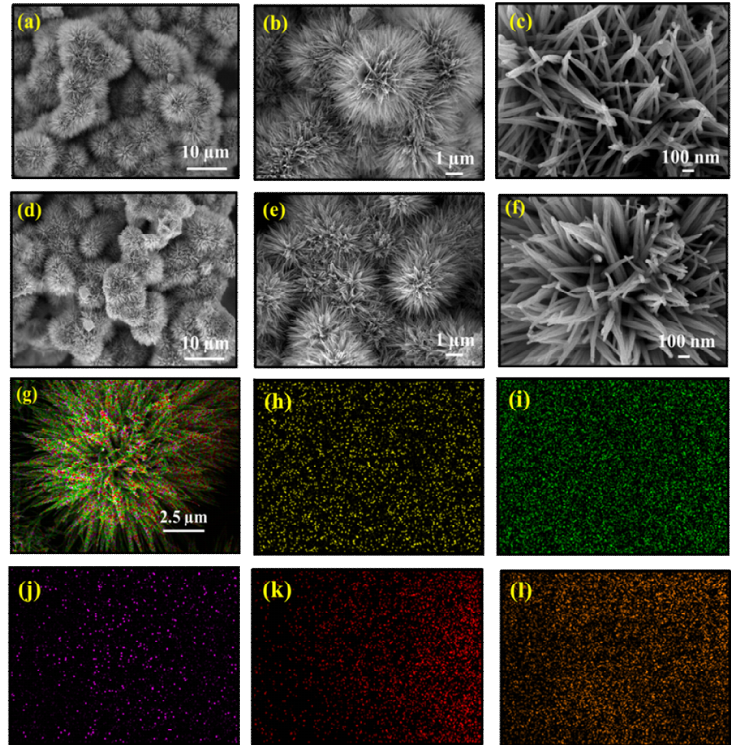
Figure 2. FESEM images of FC ( a – c ), FCCD25 ( d – f ) and nanoflower at different magnifications and ( g ) EDS mapping of FCCD25, showing the homogeneous distribution of Fe ( h ), Co ( i ), carbon ( j ), oxygen ( k ) and nitrogen ( l ).